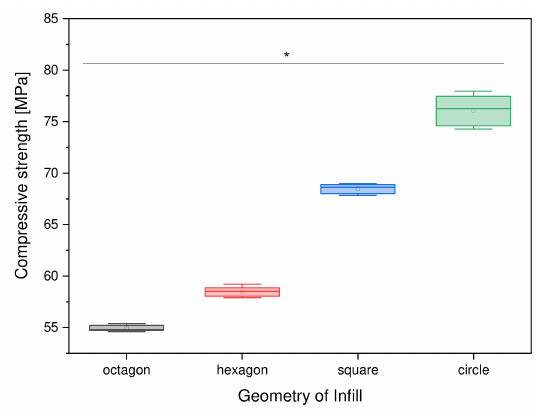
Figure 7. Compressive strength as a function of the outer geometry; n = 30; p < 0.05